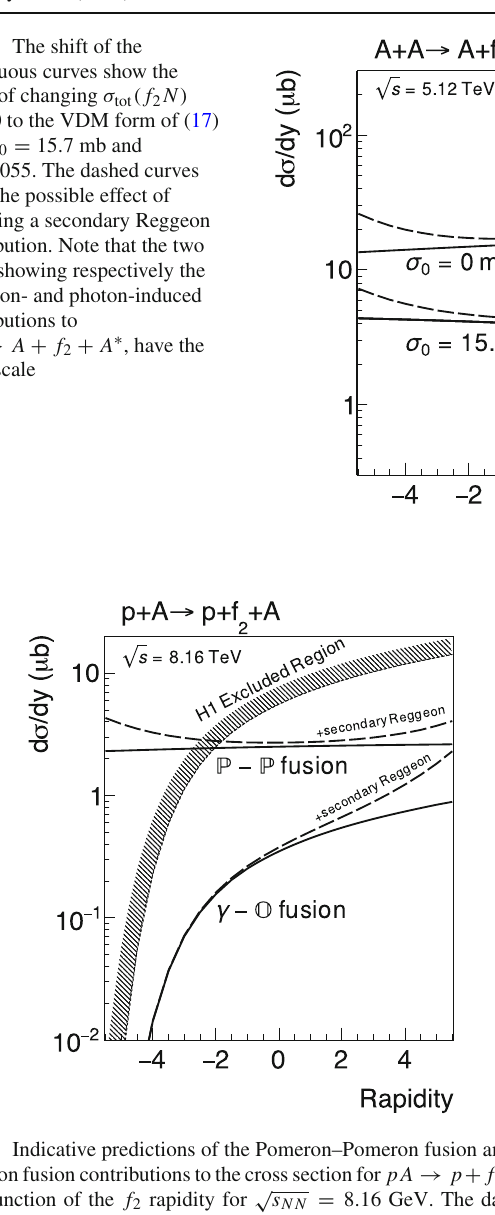
The dashed curves in Fig. 2 show the possible effect